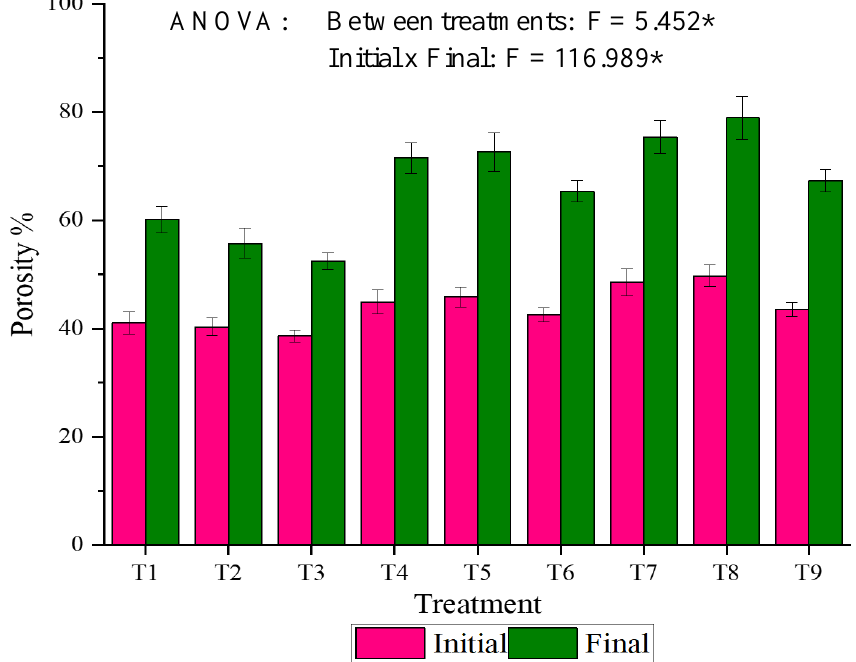
Figure 5. Profile of total porosity variations among different composting treatment groups. ‘*’ indi- cates a significant difference at p < 0.05 by ANOVA.